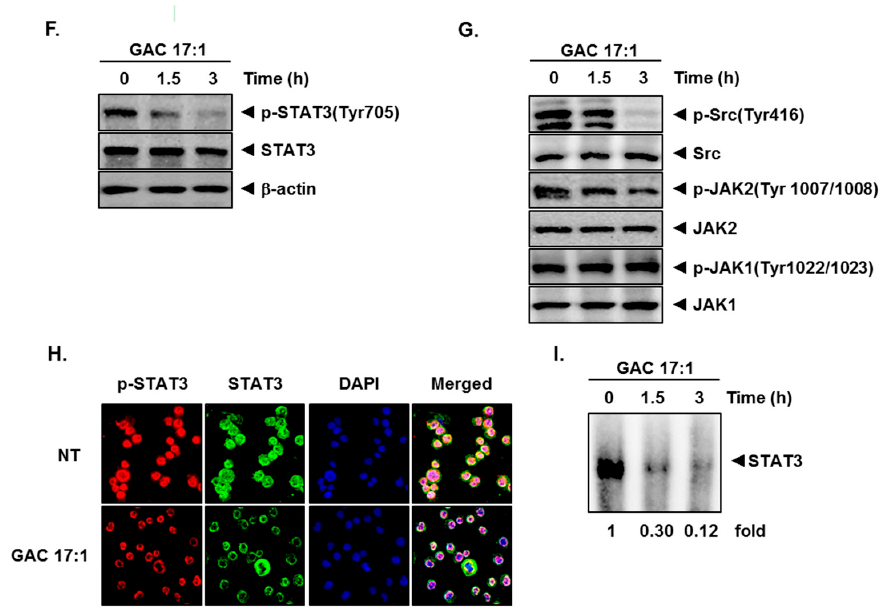
Figure 1. Inhibitory effects of GAC 17:1 on constitutively activated STAT3 in U266 cells. ( A ) The chemical structure of GAC 17:1 and GAC 15:1; ( B , C ) U266 cells and PBMCs (1 × 10 4 cells/well) were treated with various concentrations of GAC 17:1 for 24 h and cell viability was determined by MTT assay; ( D ) U266 cells (5 × 10 5 cells/well) were treated with GAC 17:1 (50 μ M) or GAC 15:1 (50 μ M) for 3 h. Whole-cell extracts were prepared then equal amount of lysates were subjected to western blot analysis for p-STAT3 (Tyr705), STAT3, and β -actin; ( E ) U266 cells (5 × 10 5 cells/well) were incubated with GAC 17:1 (30 or 50 μ M) for 3 h. Thereafter, equal amounts of lysates were analyzed by western blot analysis using antibodies against for p-STAT3 (Tyr705), STAT3, and β -actin; ( F , G ) U266 cells (5 × 10 5 cells/well) were treated with GAC 17:1 (50 μ M) for the indicated time. Lysates from the cells were analyzed using western blot analysis for p-STAT3 (Tyr705), STAT3, p-JAK1 (Tyr1022/1023), JAK1, p-Src (Tyr416), and Src; ( H ) After 3 h of GAC 17:1 (50 μ M) treatment, the cells were fixed and permeabilized. STAT3 (green) and p-STAT3 (red) were immunostained with rabbit anti-Stat3 and goat anti-p-STAT3 respectively followed by FITC-conjugated secondary antibodies, then nucleus (blue) was stained with DAPI. The fourth panels show the merged images of the first, second and third panels; ( I ) U266 cells (5 × 10 5 cells/well) were incubated with the GAC 17:1 (50 μ M) for 1.5 or 3 h. Nuclear extracts were prepared for detection of STAT3 binding activities and testing was performed by EMSA.